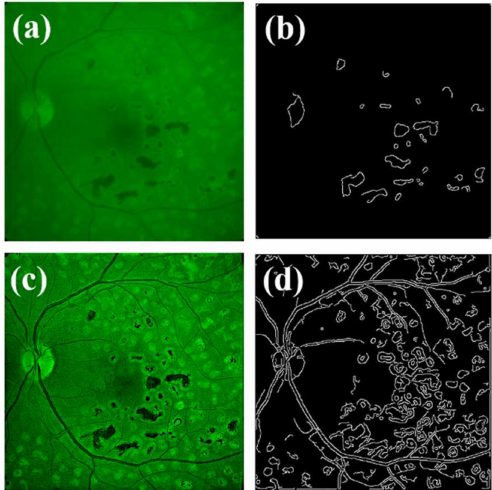
Figure 12. Original image from a diabetic retinopathy eye. ( a ) Edge segmentation of original image. ( b ) Restored image ( c ) and edge segmentation of restored image ( d ).